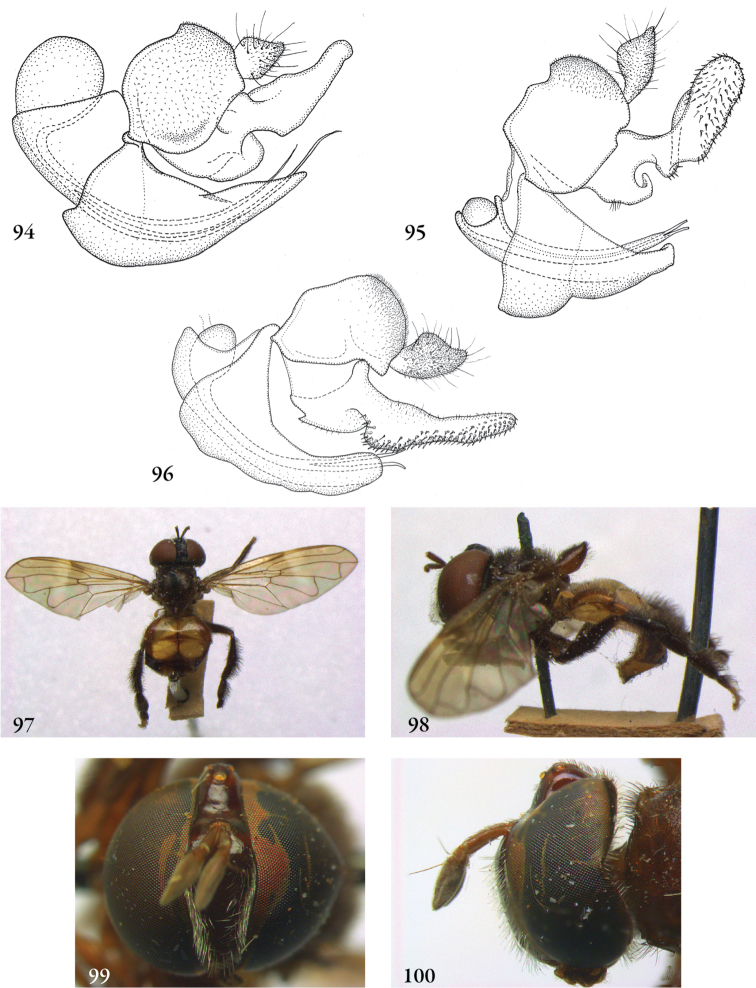
94–96
Heliodon, male genitalia: 94
Heliodon doris (holotype) 95
Heliodon tiber (holotype) 96
Heliodon gloriosus (holotype of Microdon aurivesta Hull, jun. syn.) 97–98
Hypselosyrphus amazonicus female (holotype Microdon scutellaris Shannon): 97 habitus dorsal 98 habitus lateral 99–100
Hypselosyrphus trigonus male (holotype): 99 head frontal 100 head lateral.